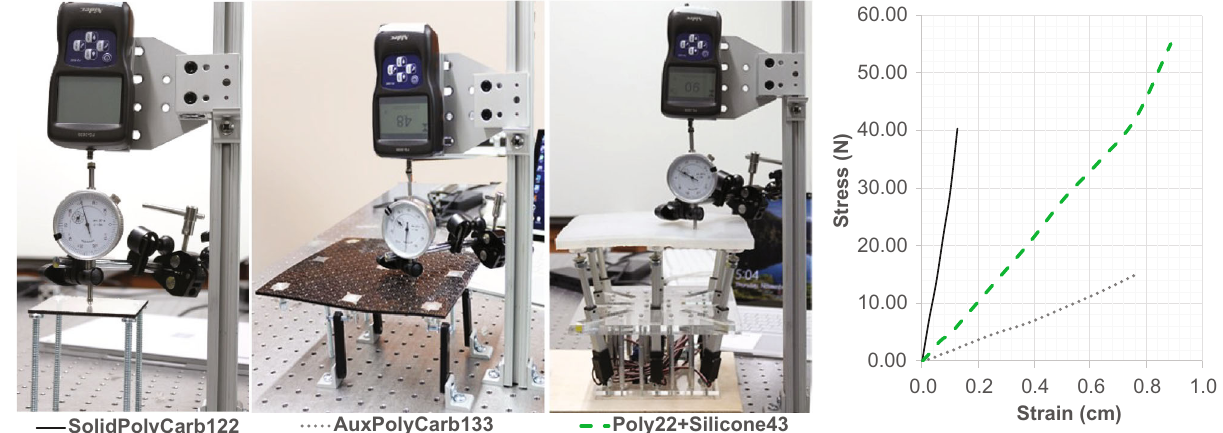
AuxPolyCarb133 Poly22+Silicone43SolidPolyCarb122 Fig. 5 Stress test. Stress test is performed on the different materials and auxetic structures. Solid Polycarbonate of 3.1mm (0.122 ” ) thick, (SolidPolyCarb122, represented with the solid black line on the graph). A 3.34mm (0.133 ” ) thick polycarbonate with the auxetic structural cut, without coating (AuxPolyCarb133, represented with the gray dotted line in the graph). The fi nal surface of the device with the 5.5mm (0.22 ” ) thick polycarbonate and the silicone coating, 10.1mm (0.43 ” ) total thickness (Poly22-Silicone43, represented with the green dashed line on the fi nger scale forces, generally humans achieve around 40 N of force when fi nger pressing with a neutral wrist 31 .